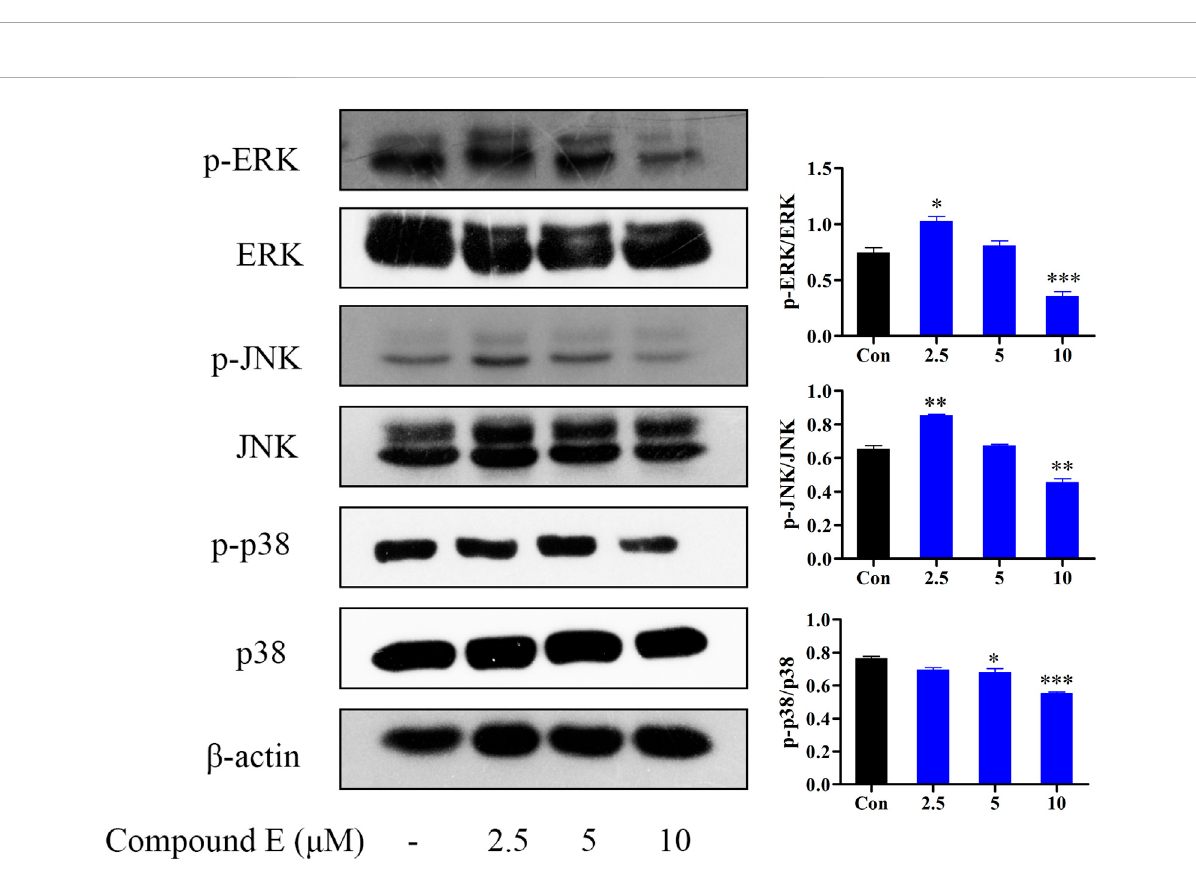
FIGURE 9 Effect of compound E on NF- κ B signaling pathway in HCT116 cells. Cells were pretreated with the various concentrations of compound E (2.5, 5 and 10 μ M) for 24 h. The expression of phospho-ERK, ERK, phospho-JNK, JNK, phospho-p38, p38 were analyzed by Western blot. *** p < 0.001, ** p < 0.01, * p < 0.05 vs. control group. The error bars represent the mean ± SD for three independent